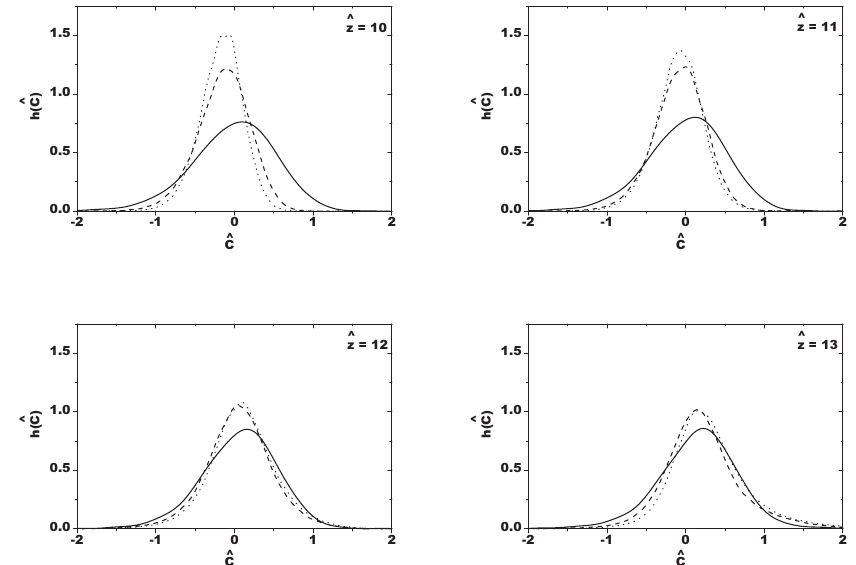
FIG. 10. Normalized spectrum at a different length of the undulator: ^ z (cid:3) 10 – 13 . Solid, dashed, and dotted lines correspond to the fundamental, 3rd, and 5th harmonic,